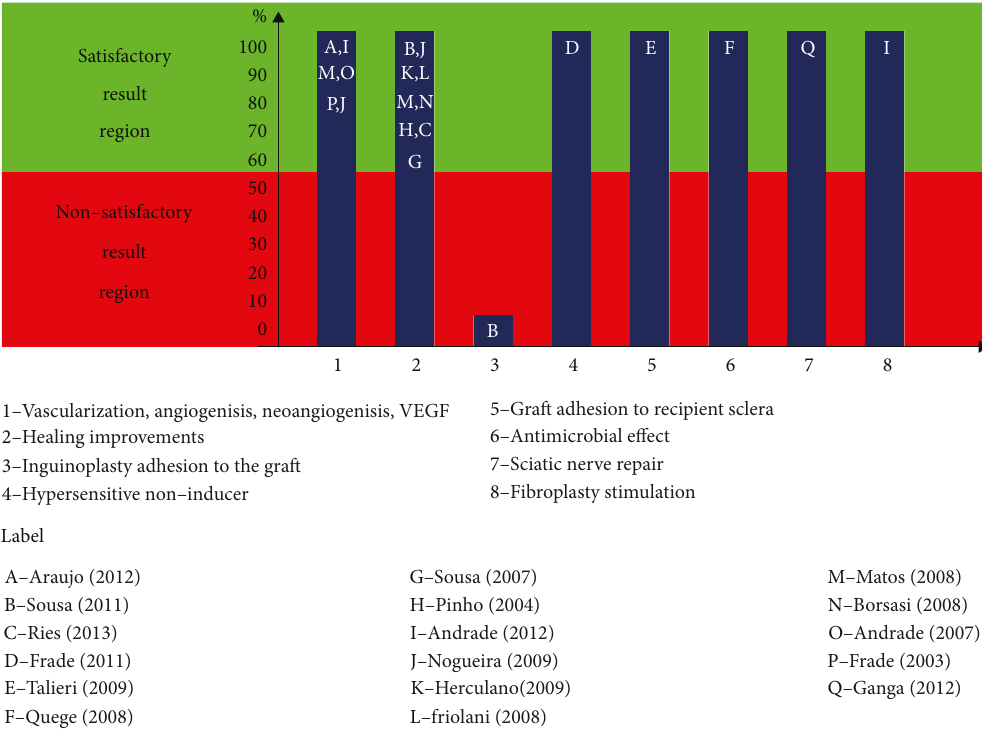
Figure 2: Main results obtained with the use of LBM in direct application, checked in the publication-surveyed 1